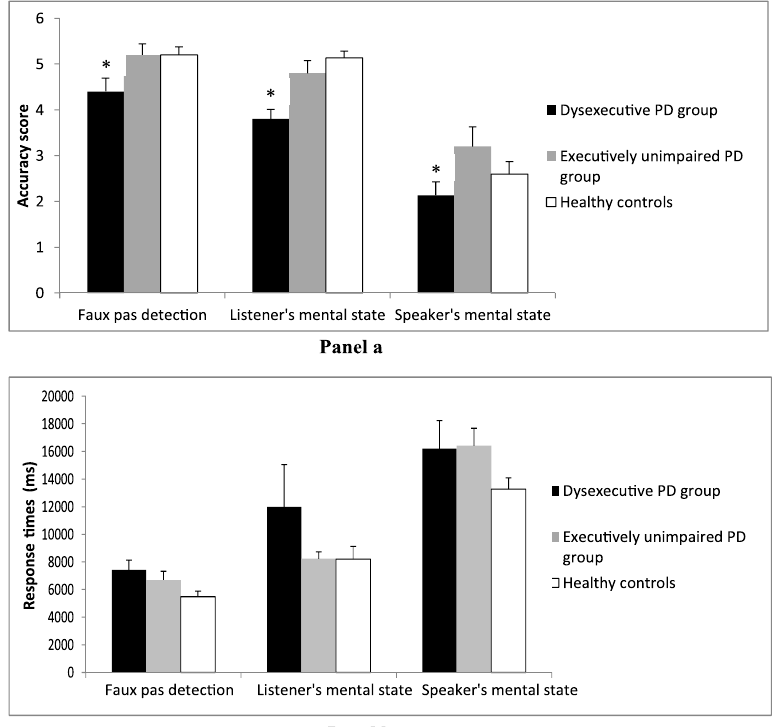
Fig. 1. The Figure illustrates accuracy (panel a) and response times (panel b) of the subjects in the PD and HC groups on the faux pas recognition tasks. ∗ Indicates a signi fi cant difference between the dysexecutive PD group and the two other experimental